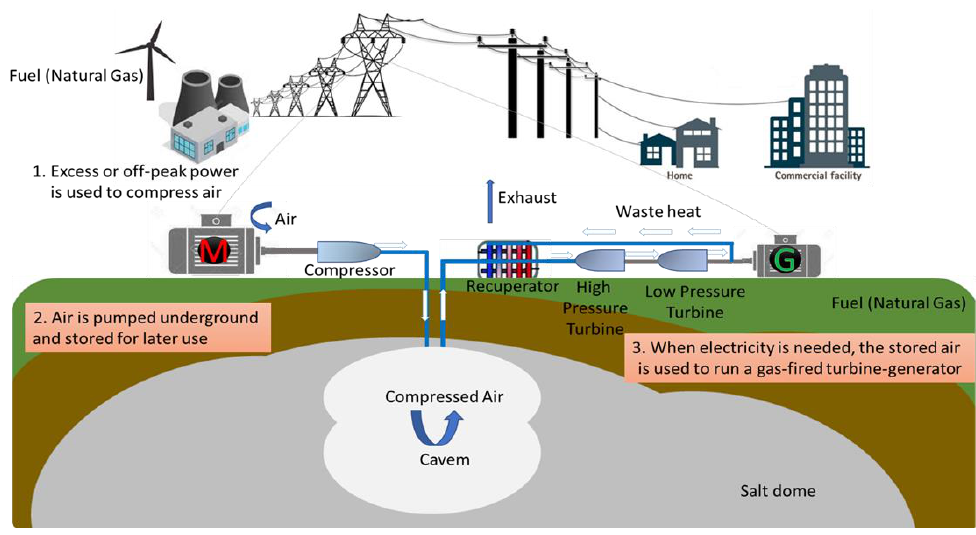
Figure 3. Components of the CAES